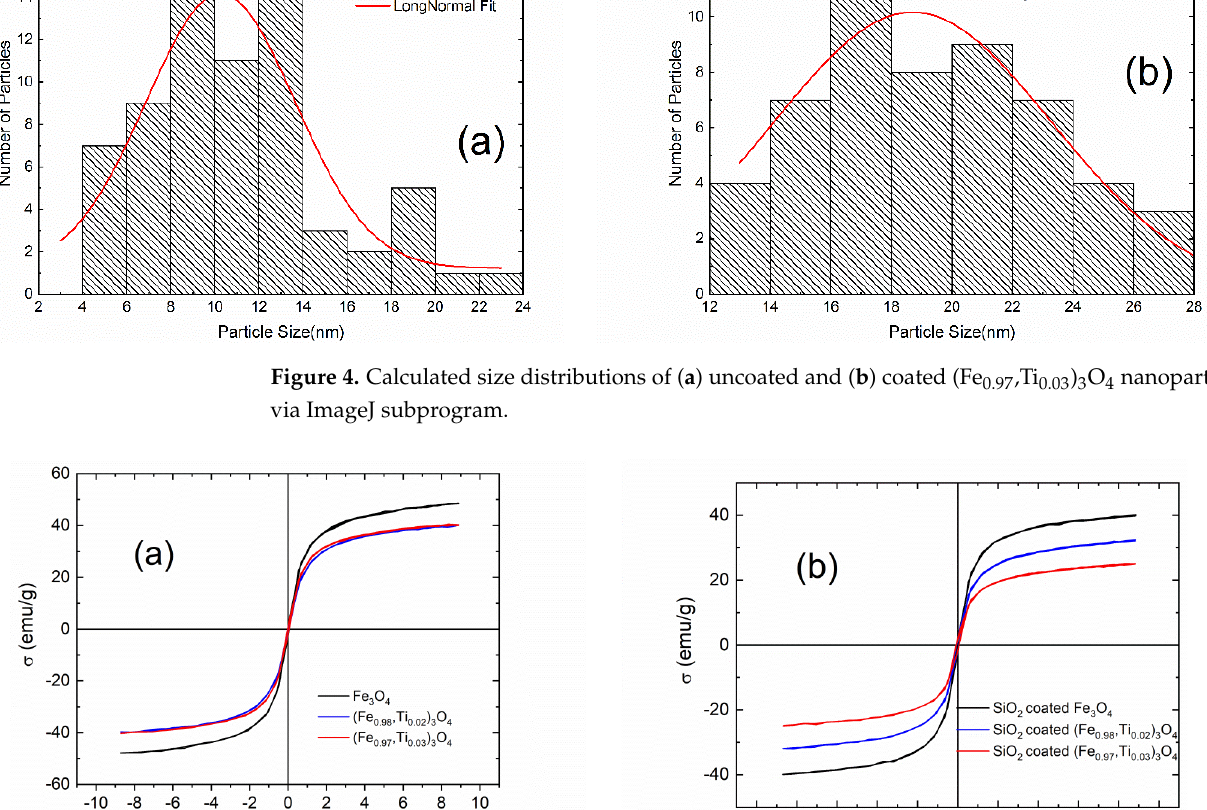
Figure 4. Calculated size distributions of ( a ) uncoated and ( b ) coated (Fe 0.97 ,Ti 0.03 ) 3 O 4 nanoparticles via ImageJ subprogram.